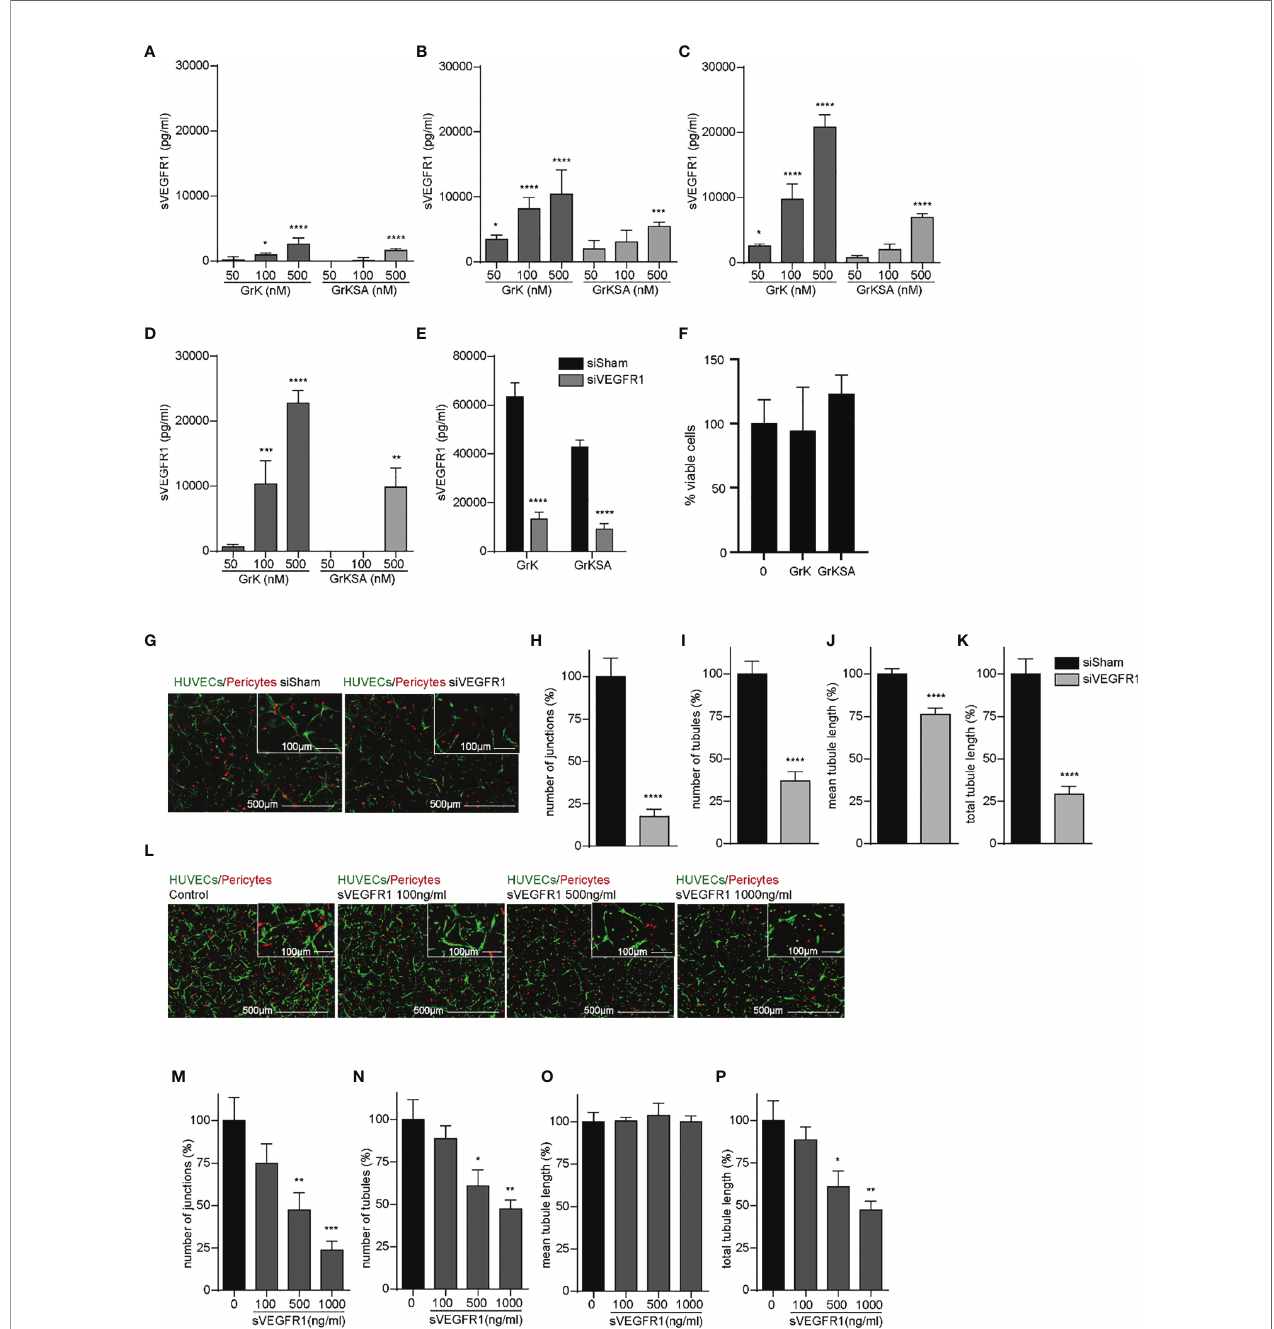
FIGURE 2 | GrK induces sVEGFR1 release from endothelial cells. HUVECs were treated with different concentrations of GrK or GrKSA. The conditioned medium was harvested and the level of sVEGFR1 was measured by Luminex. A time and concentration dependent increase of sVEGFR1 levels was observed after GrK(SA) treatment for (A) 1h, (B) 6h, (C) 24h, and (D) 48h. Data were corrected for background signal, n=4. (E) HUVEC GFP cells were transfected with siVEGFR1 (siFlt1) and a non-targeting siRNA (siSham). After incubation with 500 nM GrK(SA), inhibition of VEGFR1 shows signi fi cant lower sVEGFR1 levels. n=12. (F) HUVEC GFP cells were incubated with 500nM of GrK(SA) and detected by cell proliferation reagent WST-1. n=4. (G – K) The effect of VEGFR1 inhibition in an angiogenic 3D co- culture assay was investigated for each parameter. Representative fl uorescent microscope images of GFP-labeled HUVECs(green) in co-culture with dsRED-labeled pericytes (red) in a 3D collagen matrix during vascular formation. Shown are the results of siSHAM and siVEGFR1. Scale bar =500µm. Right corner corresponding to the inset, scale bar=100µm. n ≥ 15. (L – P) Effect of sVEGFR1 release was investigated by directly adding sVEGFR1 to the angiogenic co-culture assay. Representative fl uorescent microscope images of GFP-labeled HUVECs (green) in co-culture with dsRED-labeled pericytes (red) in a 3D collagen matrix during vascular formation. Shown are the results of an untreated control and after stimulation with different concentrations of sVEGFR1. Scale bar=500µm. Right corner corresponding to the inset, scale bar=100µm.n ≥ 6. Results are depicted as mean ± SEM. *P < 0.05; **P < 0.01; ***P < 0.001; ****P < 0.0001, compared to